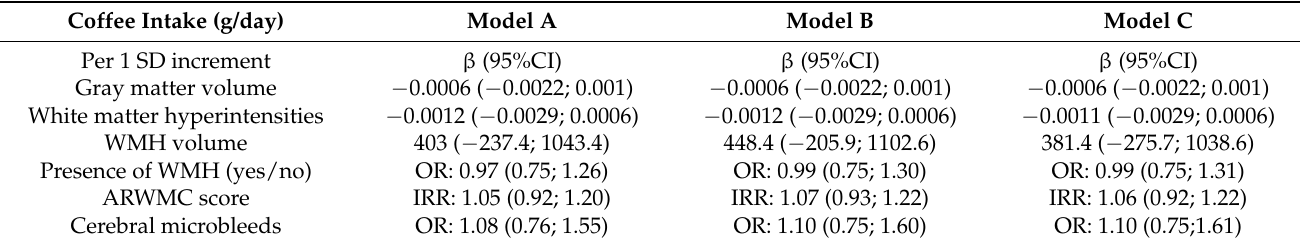
Table 2. Associations between coffee drinking and cerebral MRI findings.